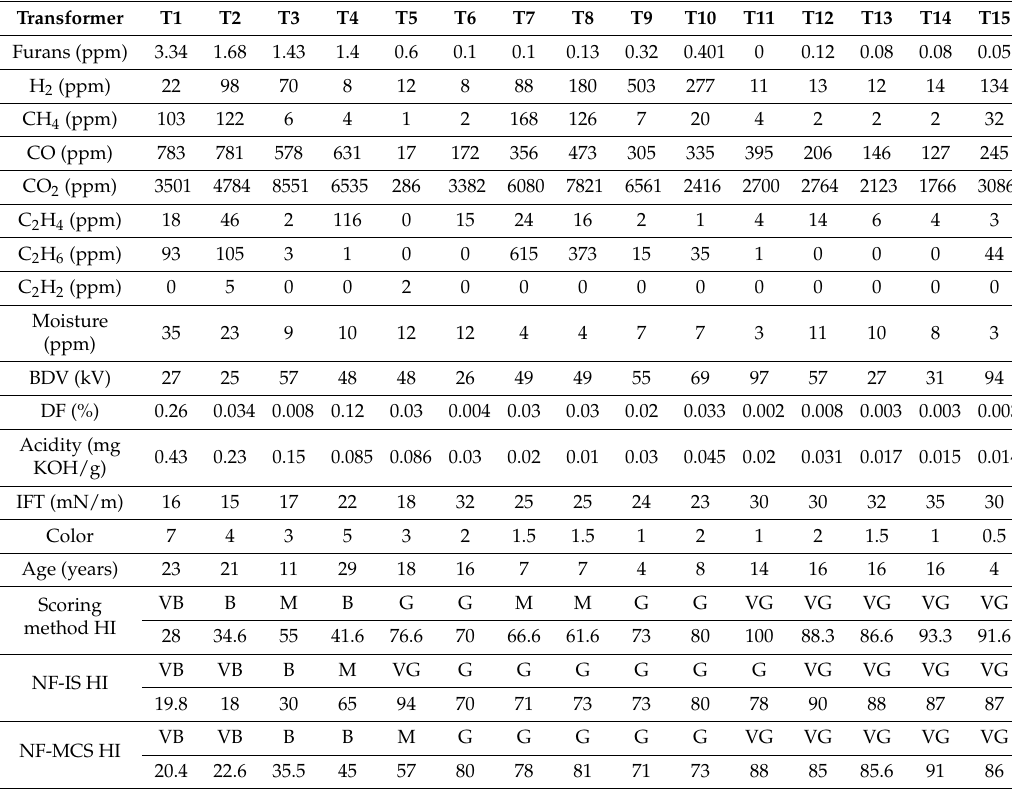
Table 1. HI and assessments of testing transformers based on scoring and NF methods (15 transformers).